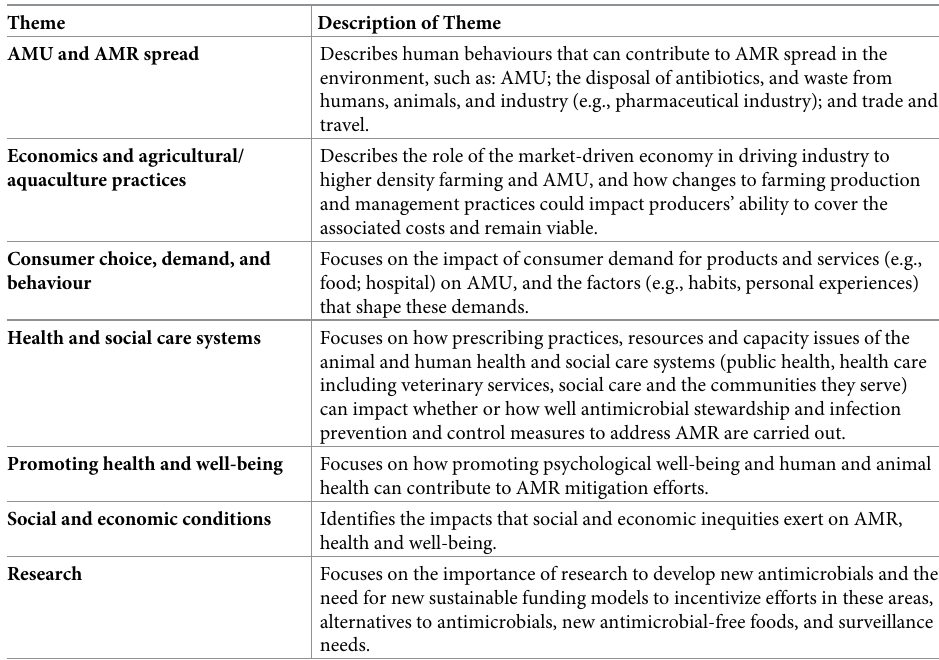
Table 1. Description of the seven